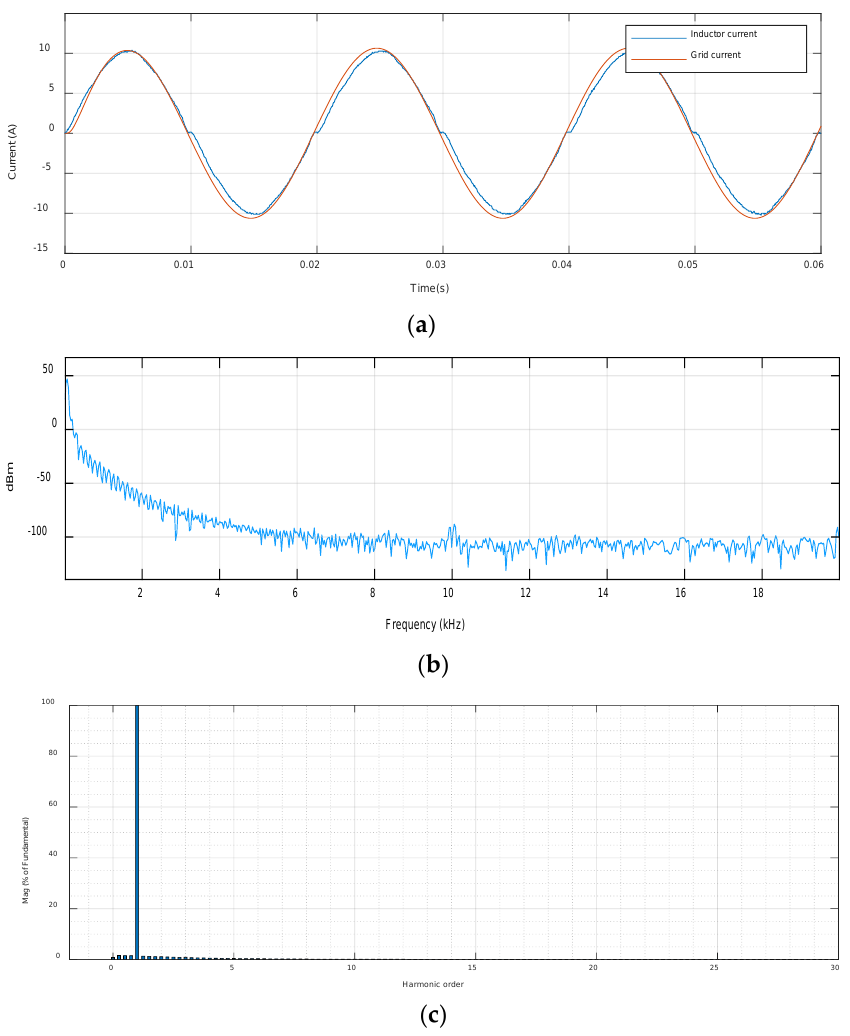
Figure 13. System response with control: ( a ) I grid vs. I L with THD_ I grid = 1.747%, ( b ) spectrum analysis of I grid , ( c ) Harmonics contents of I grid.